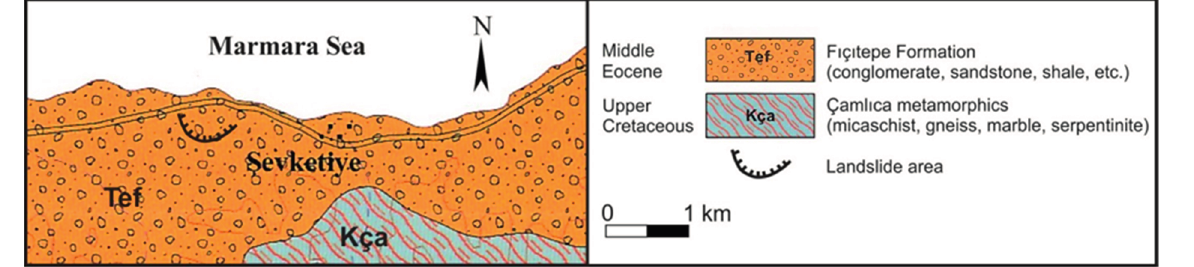
Figure 2. The geological map of Sevketiye area (modified [39]).